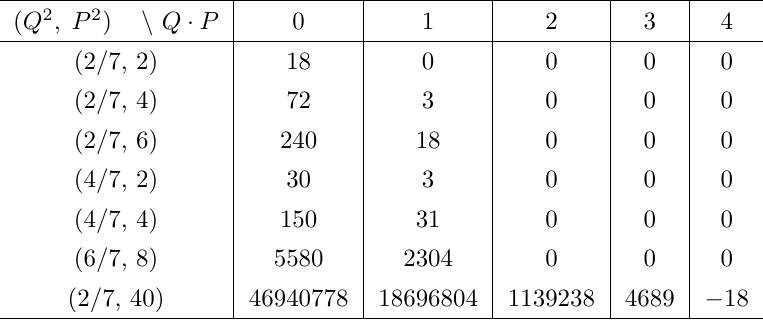
Table 10 . Index of horizon states for the 7 A orbifold of K 3 .